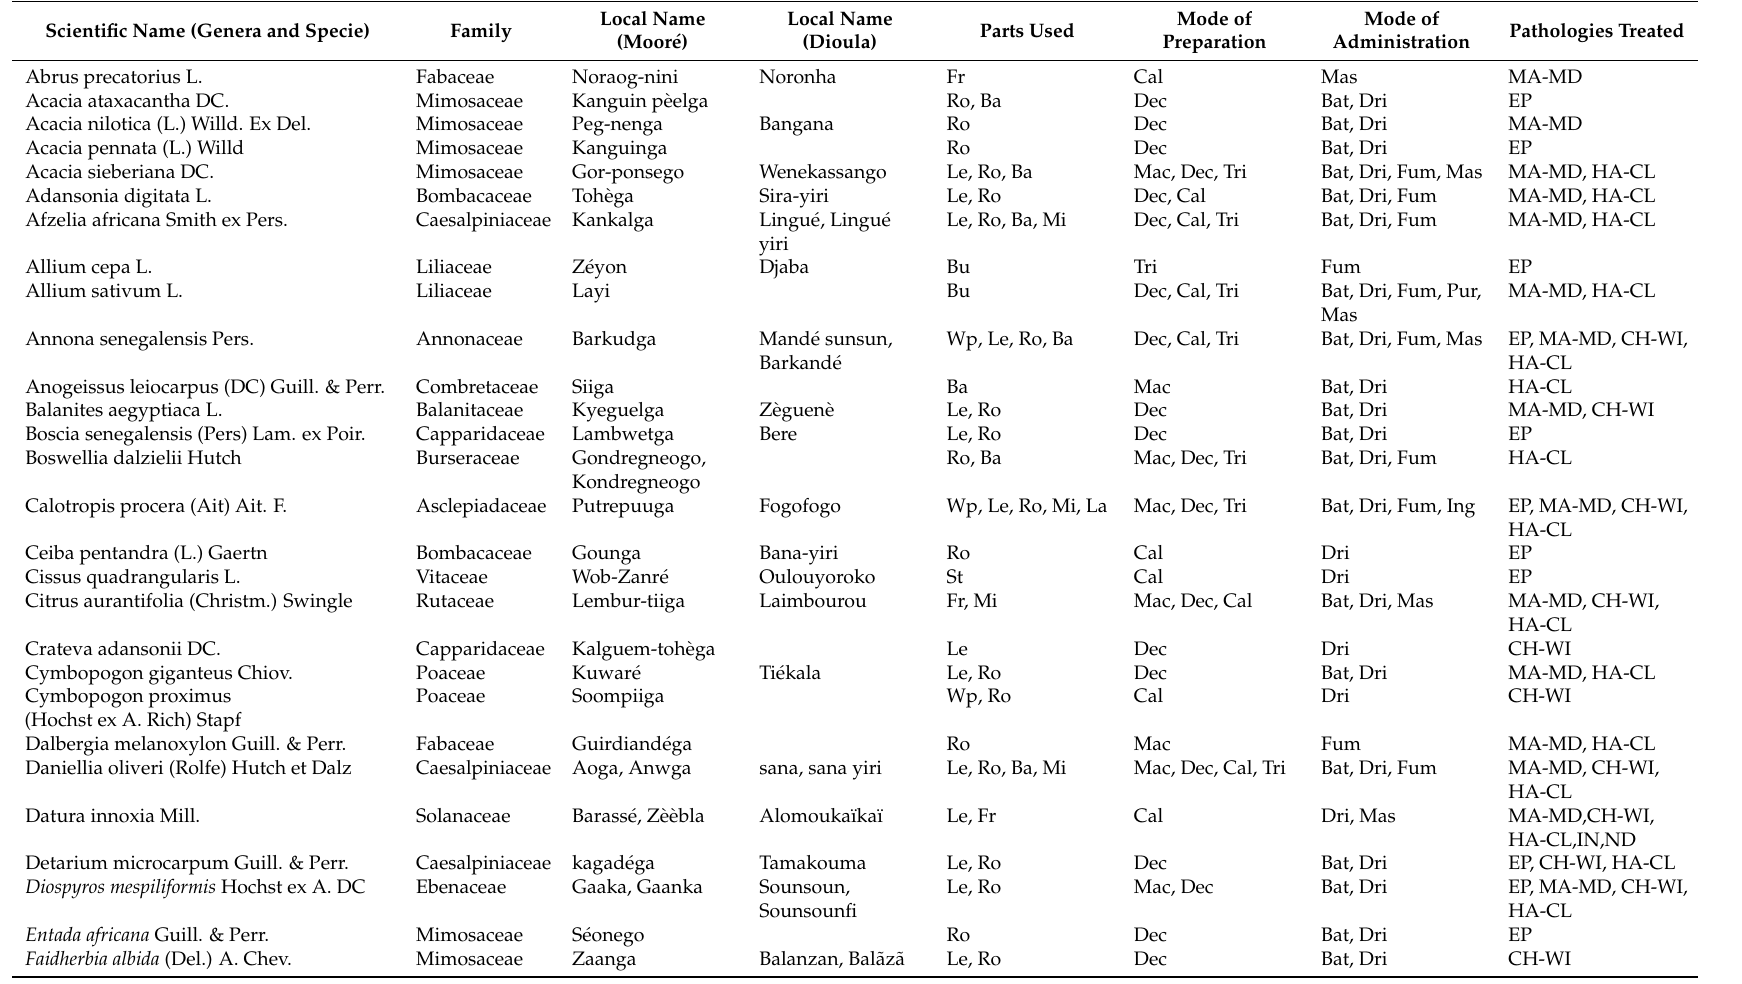
Table 1. Global information on plants used in various